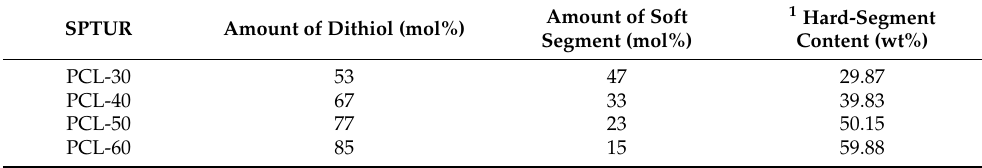
Table 1. Designations of the